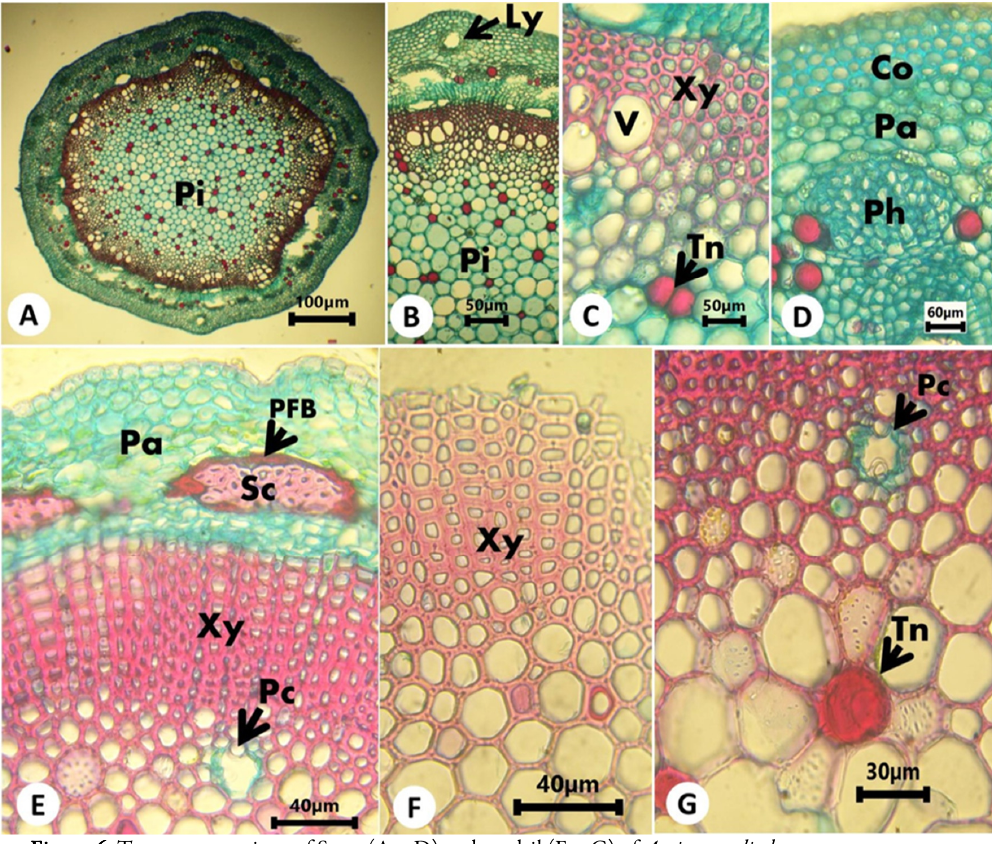
Figure 6. Transverse sections of Stem (A – D) and tendril (E – G) of A. cissampeliodes Pi = pith, Xy = xylem, Ph = phloem, Fb = fibre, G = lysigenous cell, Pa = cortex parenchyma, Co = collenchyma, V = vessel, sd = tanniferous